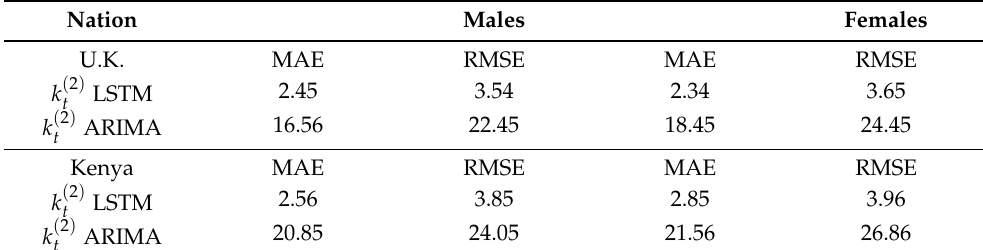
Table 4. LSTM & ARIMA Performances.